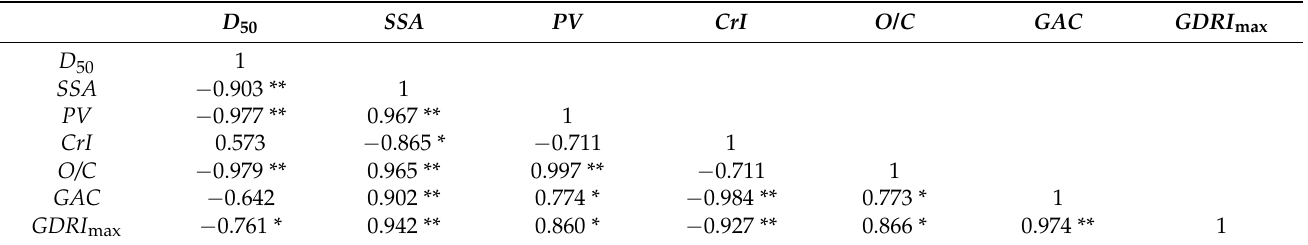
Table 3. Pearson correlation analysis of microstructure parameters with GAC and GDRI .